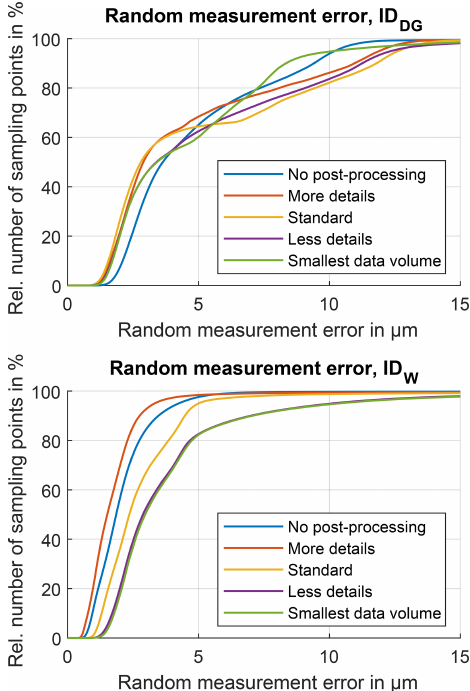
Figure 9. Cumulative visualization of the random measurement er- rors for different polygonization settings for both gear wheels ID DG and ID W